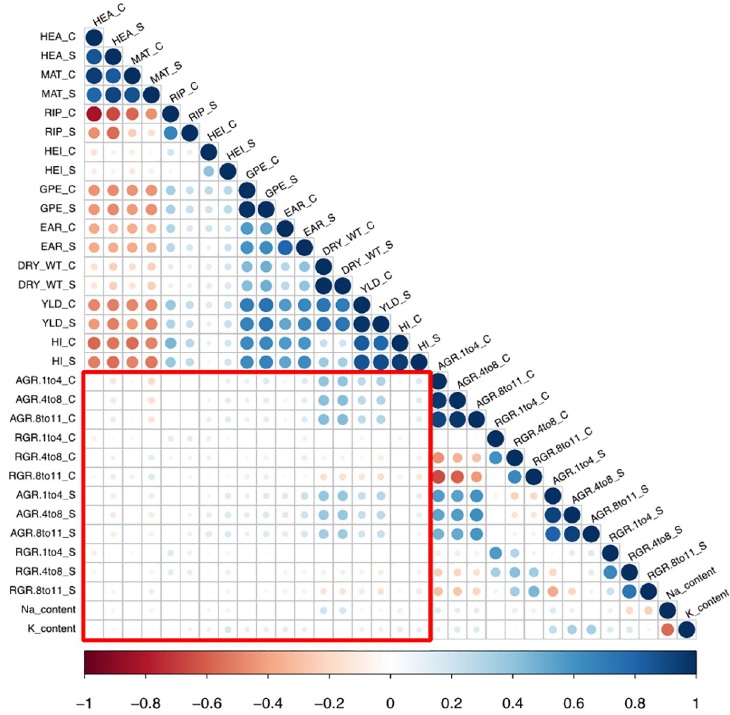
Fig 4. Correlations among all traits measured under control and saline conditions in this study. The red square encompasses correlations between the traits measured in the field at ICBA and under controlled conditions at TPA. The size and the color of the circles refer to the strength and the significance of the correlations, respectively. Nonsignificant correlations are indicated by blank cells. Flowering time (HEA), maturity time (MAT), ripening period (RIP), plant height (HEI), ear number per plant (EAR), grain number per ear (GPE), dry mass per m 2 (DRY_WT), yield (YLD), and harvest index (HI) are measured in the field under both control (_C) and saline (_S) conditions at ICBA. Absolute growth rate (AGR) and relative growth rates (RGR) are measured for the time-intervals 1–4, 4–8, and 8–11 days after salt treatment under both control (_C) and saline (_S) conditions at TPA. Sodium (Na) and potassium (K) contents were measured by flame photometer from leaves collected from plants grown at TPA under saline conditions.